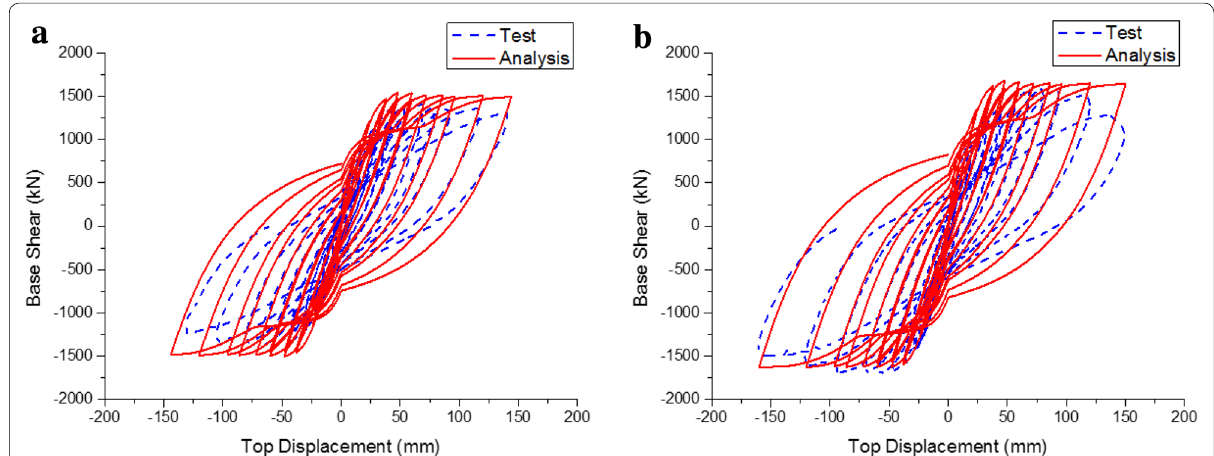
Fig. 15 Comparisons between the experimental data and the analytical results using the classical fiber models: a CW-1 and b CW-2.